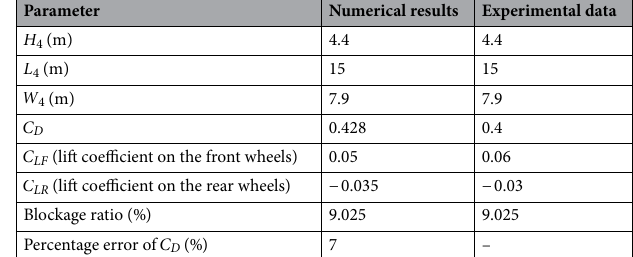
Table 2. C D and C L of the benchmark of the LRD4 for experimental and numerical results.